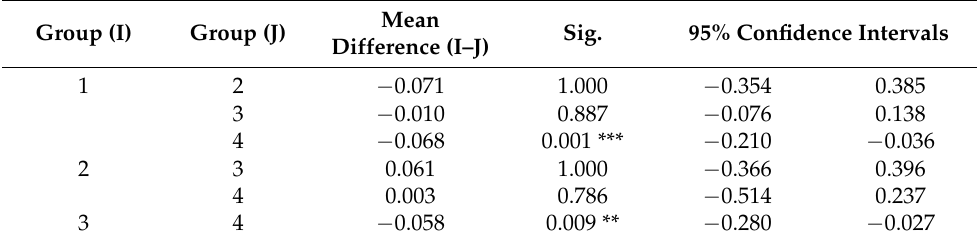
Table 10. Multiple comparisons of mixed media on satisfaction.